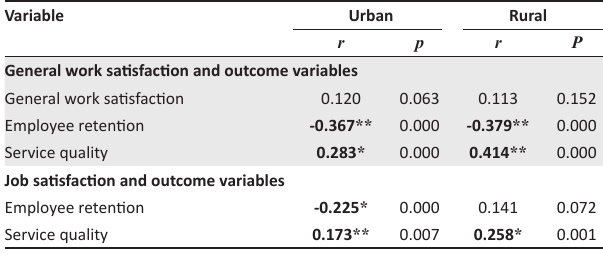
TABLE 4: Hypotheses testing: Outcomes of employee satisfaction.